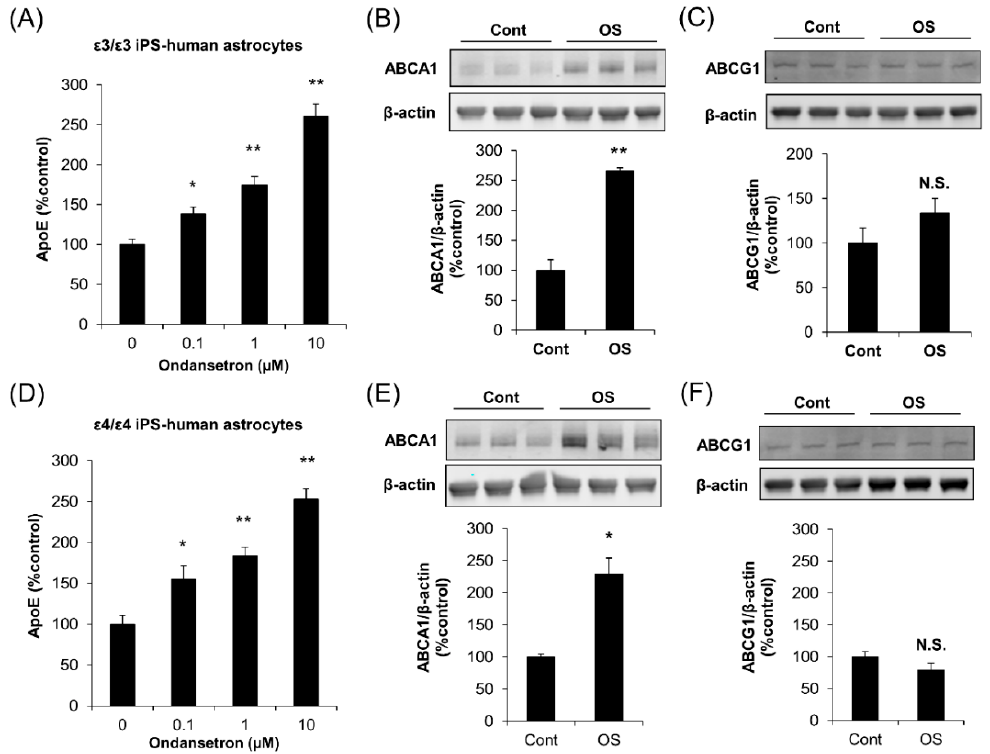
Figure 5. OS increases apoE secretion in astrocytes derived from human-induced pluripotent stem cell. Human iPSC-astrocytes with APOE ε 3/ ε 3 ( A – C ) and APOE ε 4/ ε 4 ( D – F ) genotypes were cultured and treated with the indicated concentrations of OS for 24 h, and apoE levels in culture media were determined by ELISA ( A , D ), and cellular ABCA1 ( B , E ) and ABCG1 ( C , F ) levels were analyzed by Western blotting using β -actin as a loading control. Data represent mean ± SD ( n = 3, biological replicate group). * p < 0.05, ** p < 0.01, NS; non-significant; Tukey-Kramer test .